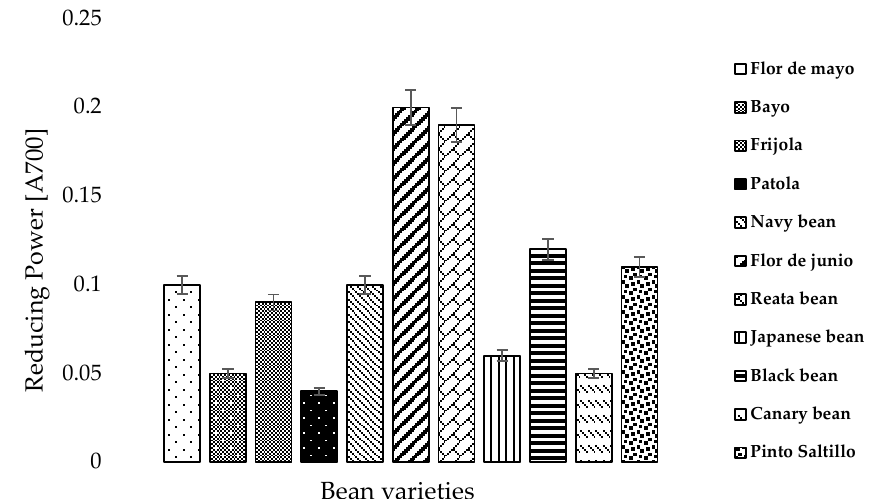
Figure 2. Reducing power of bean varieties grown in the state of Zacatecas, Mexico, classified in three major groups: (1) High level, (2) Medium level and (3) Low level. Data are shown as the mean ± standard error ( n = 3).